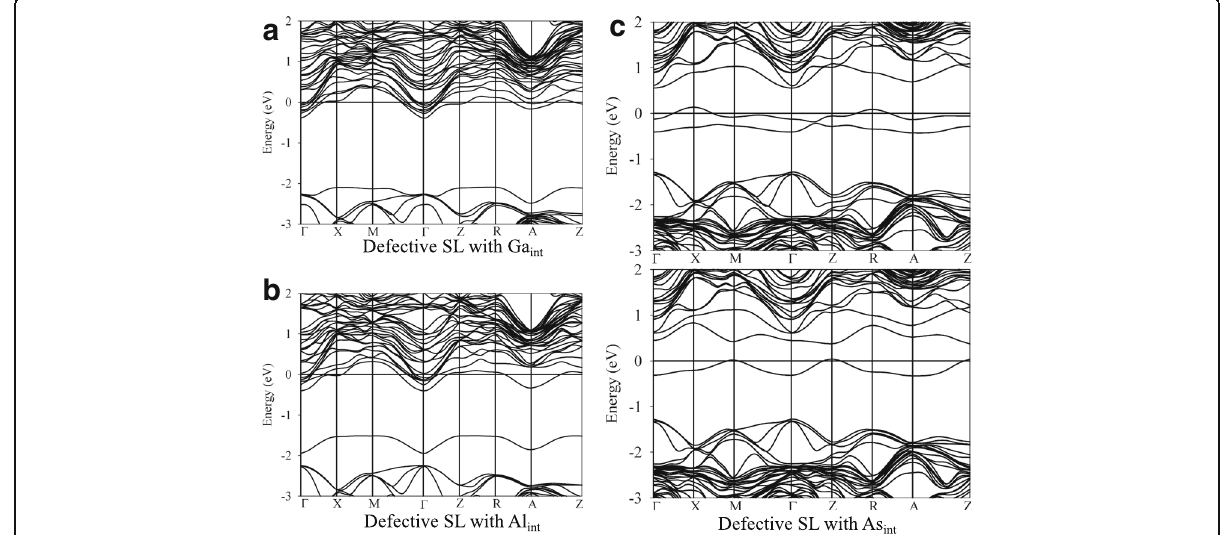
Fig. 9 The band structures of defective GaAs/AlAs superlattice with a Ga int defect, b Al int defect and c As int defect. X int (X = Ga, Al, or As) X